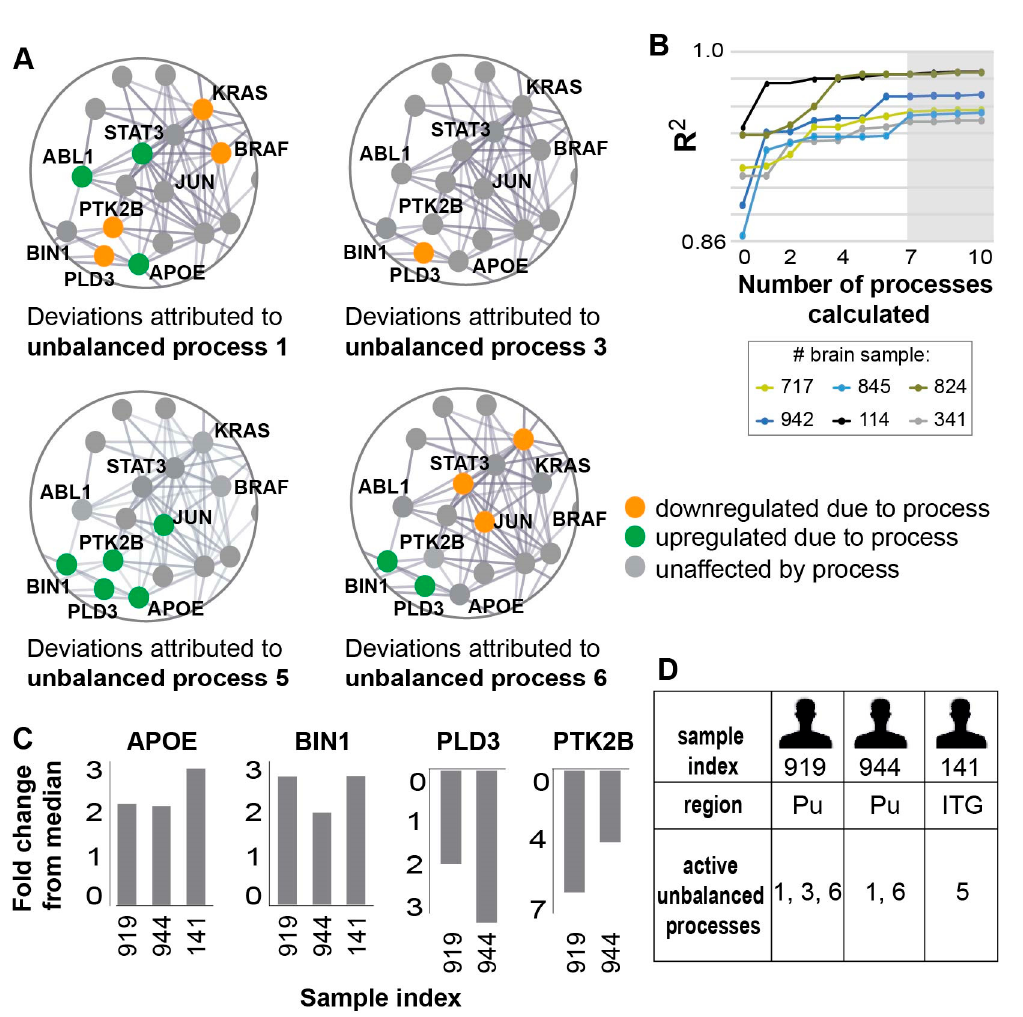
Figure 4. Seven unbalanced processes were identified in the 951 samples tested, underlying the disparities in biomarker expression levels in di ff erent samples. ( A ) Zoomed in images of four of the seven unbalanced processes identified in the dataset: 1,3, 5, and 6. For each process, the deviations in expression levels of nine transcripts are shown, demonstrating how di ff erent unbalanced processes can a ff ect the expression levels of the same transcripts, sometimes in opposite directions. The complete information regarding the seven unbalanced processes and the transcripts a ff ected by them can be found in Table S1. ( B ) R 2 values of selected samples were calculated by plotting the natural logarithm of the experimental data ln ( X i ( k )) vs. ( ) G k i for different values of α . The value of R 2 approaches 1 as more unbalanced processes are added to the calculation. Mathematically, 951 unbalanced processes are calculated for each patient. However, not all of them are significant. The figure shows that the R 2 plots representing different patients reach a plateau after seven processes, suggesting that the first seven unbalanced processes are necessary to reproduce the experimental data, while the rest of the processes represent random noise in the system. Six selected brain samples are shown. The gray box highlights that the addition of the unbalanced process 7 α> had no significant effect on the R 2 value for these samples. ( C ) Fold change in expression level of the four AD biomarkers in three selected samples—the selected samples demonstrate similar deviations in expression levels of these biomarkers. ( D ) The samples were found to harbor different sets of active unbalanced processes. Hence, similar transcript expression levels can arise from distinct altered transcriptional signatures, possibly demanding different modes of treatment as well.